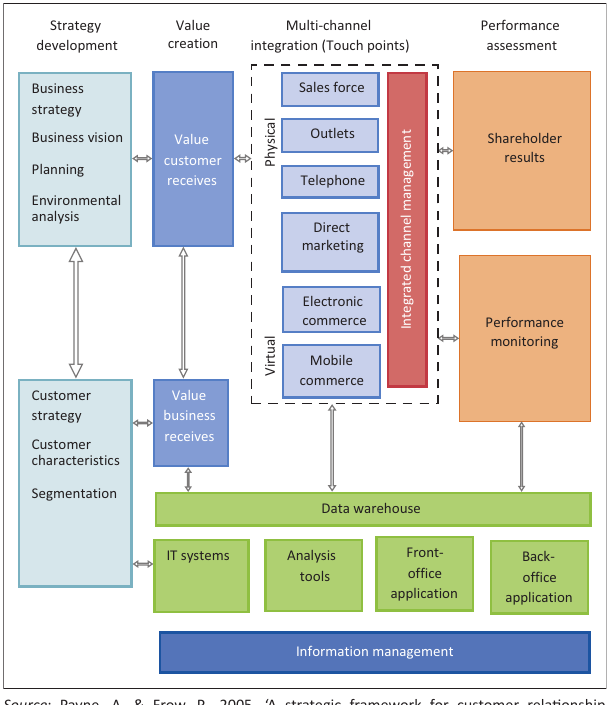
FIGURE 1: Processes forming part of customer relationship